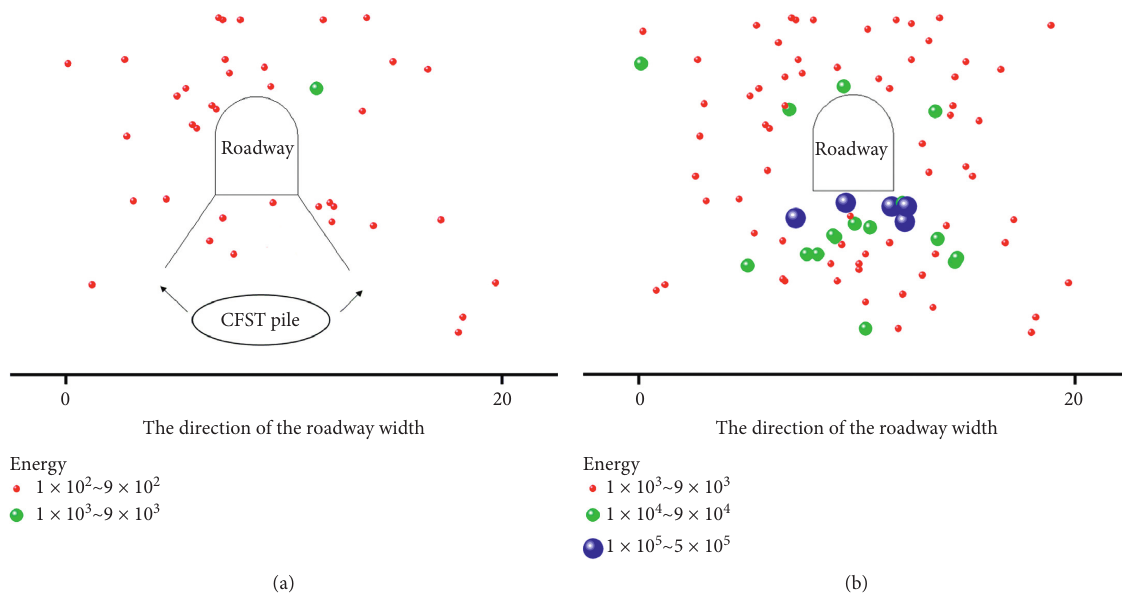
Figure 19: Microseismic events of roadway rock. (a) Floor for pressure relief and support. (b) Floor without support.